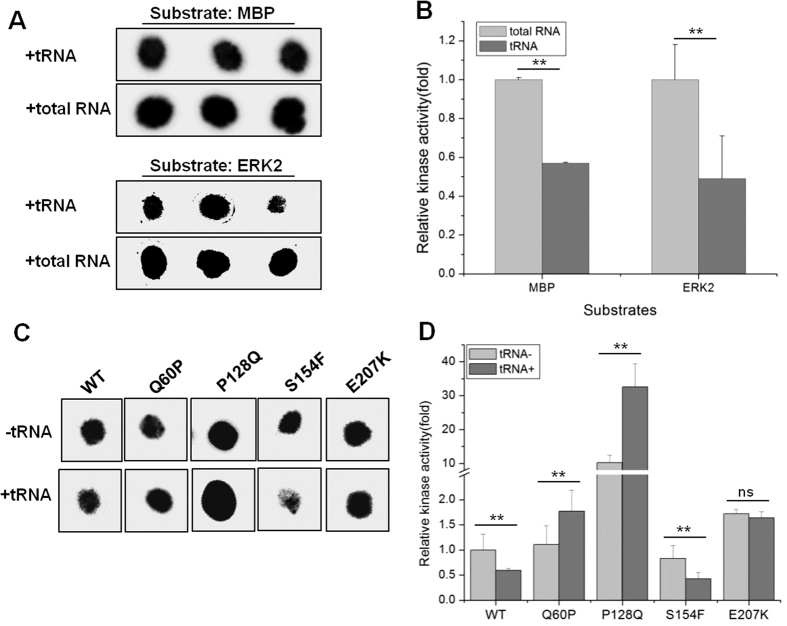
Effect on catalytic activity of the different MEK2 mutants by tRNA.(A) In vitro kinase dot blot assays using wild-type MEK2 were performed with MBP protein or ERK2 as substrate, in the presence of human tRNA or human total RNA (0.2 μg/μl). Kinase assay without MEK2 protein was used as background control. (B) MEK2 kinase activity was quantified, and normalized to the activity of wild-type MEK2 in the presence of human total RNA. Kinase assays were performed in triplicate, and error bars represent standard deviations from these replicates. **indicates P < 0.05. (C) Wild-type MEK2 or MEK2 mutants (Q60P, P128Q, S154F and E207K) were used in the kinase dot blot assays using MBP peptide as substrate, in the presence or absence of human tRNA. (D) MEK2 kinase activity was quantified, and normalized relative to the activity of wild-type MEK2 in the absence of tRNA. Kinase assays were performed in quadruplicate or triplicate, and error bars represent standard deviations from these replicates. Representative dots of kinase assays are shown. **indicates P < 0.05 relative to kinase activity without RNA, ns indicates no significant difference.